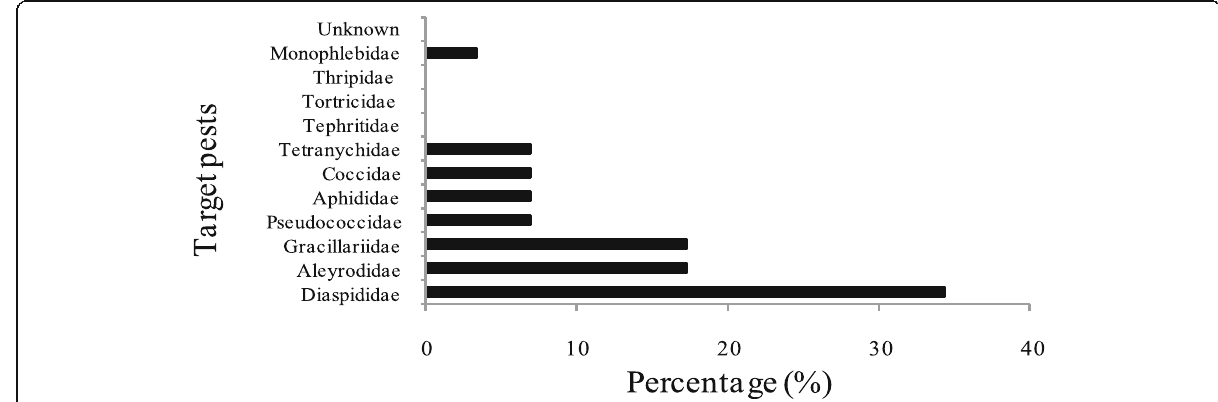
Fig. 3 Percentage of presence (%) of introduced species according to their targeted pests in Moroccan citrus orchard ( N =